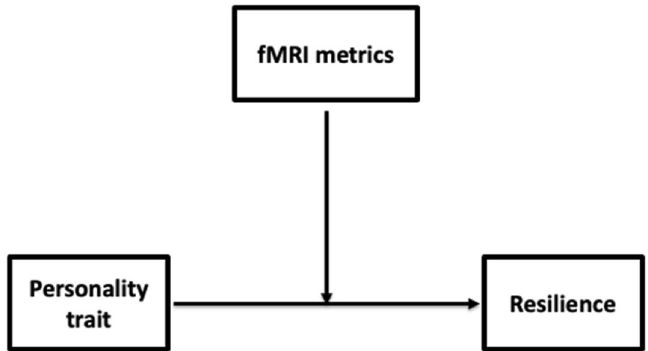
Figure 1. Conceptual model for the simple moderation analysis. Only personality trials, that were significantly associated with the resilience (extraversion, conscientiousness, neuroticism) were included in the model. The three fMRI metrics (fALFF, ReHo, DC) were included in the model as moderators. Age was considerate as a covariate.